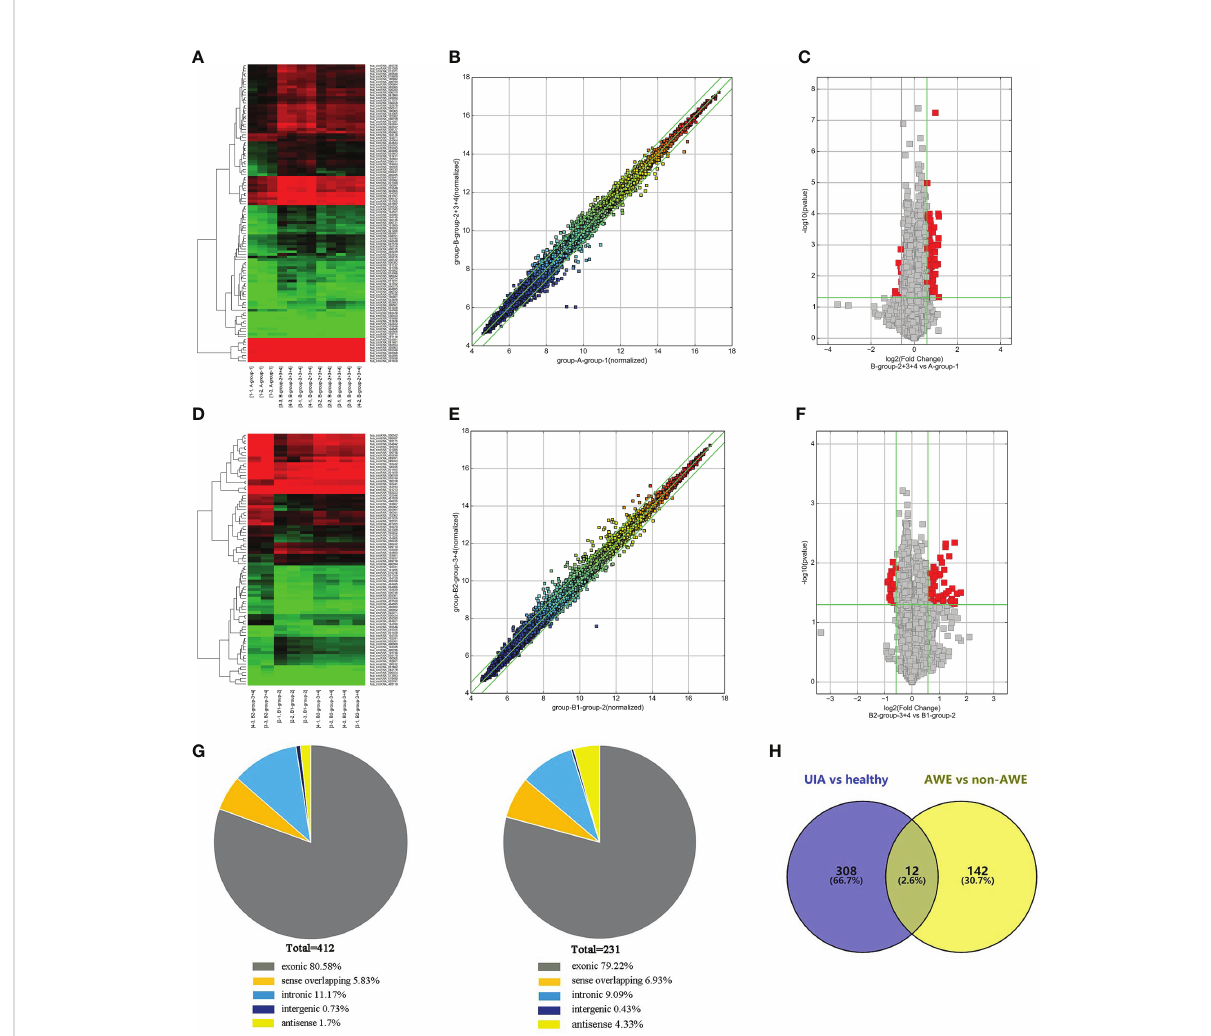
FIGURE 1 Differentially expressed circRNAs in peripheral blood identi fi ed by circRNAs microarray. (A) The hierarchical clustering of differentially expressed circRNAs between the unruptured intracranial aneurysm (UIA) and healthy control groups. Group A represented healthy control; group B represented the UIA group. (B) The scatterplot is used to assess the circRNA expression variation between the UIA and healthy control group of samples. The circRNAs above the top green line and below the green bottom line indicate more than a 1.3-fold change of circRNAs between the two compared samples. (C) Volcano Plots are used to visualize differential expression between the UIA and healthy control groups. The red point in the plot represents the differentially expressed circRNAs with statistical signi fi cance. (D) The hierarchical clustering of differentially expressed circRNAs between the UIA with aneurysm wall enhancement (AWE) and UIA without AWE. Group B1 represented UIA with AWE of samples; group B2 represented UIA without AWE of samples. (E) The scatterplot is used for assessing the circRNA expression variation between the UIA with AWE and UIA without AWE. The circRNAs above the top green line and below the green bottom line indicate more than a 1.3-fold change of circRNAs between the two compared samples. (F) Volcano Plots are used for visualizing differential expression between the UIA with AWE and UIA without AWE. The red point in the plot represents the differentially expressed circRNAs with statistical signi fi cance. (G) The genomic origin of the differentially expressed circRNAs among three groups of samples (UIA with AWE, UIA without AWE, and healthy controls). (H) A total of 12 signi fi cantly differentially expressed peripheral blood circRNAs among the three compared groups (UIA with AWE, UIA without AWE, and healthy controls) were identi fi ed by circRNA